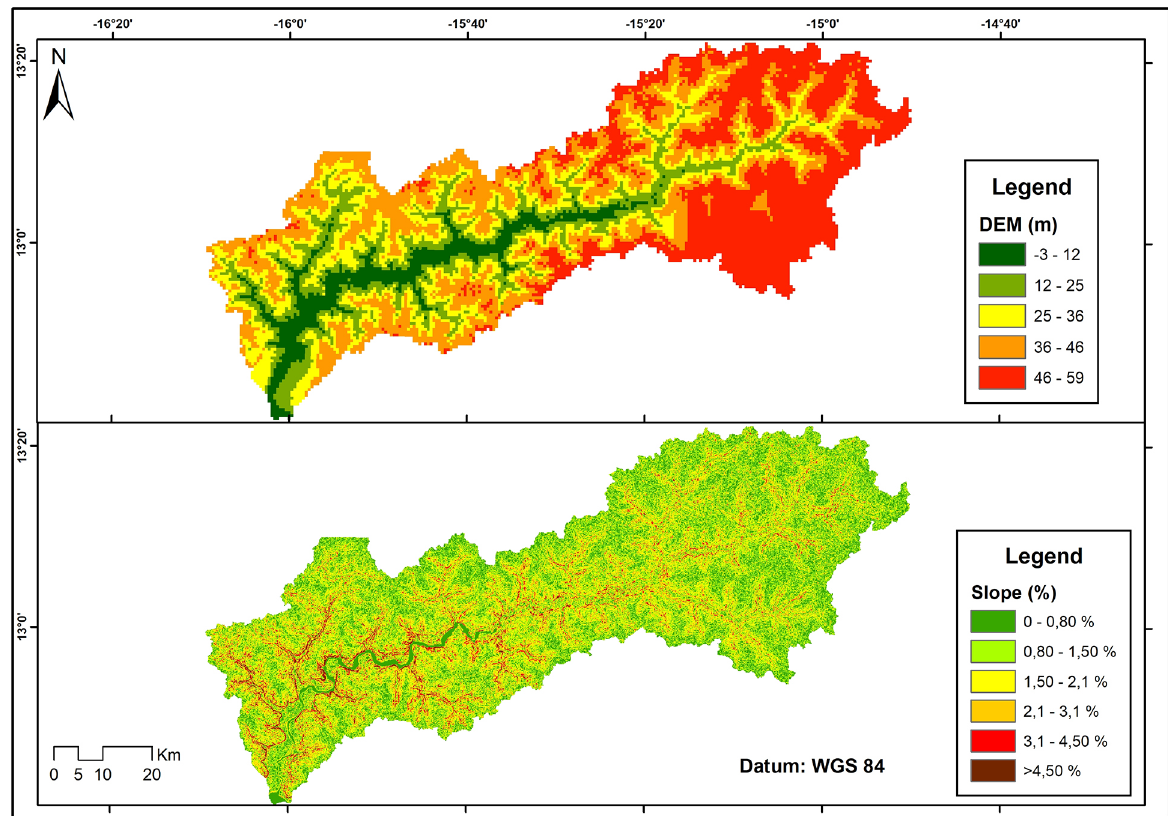
Fig. 4. Digital elevation model and slope [%] of the Soungrougrou